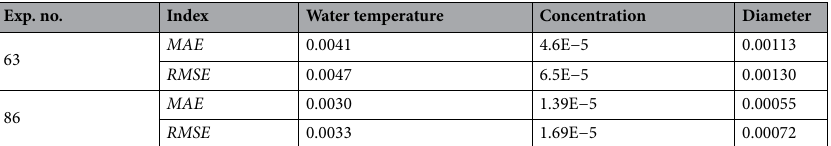
Table 3. MAE and RMSE of water temperature, frazil ice concentration and ice crystal diameter in the laboratory experiment no. 63 and no. 86.